Question: What visual encoding does this figure use to show its data?
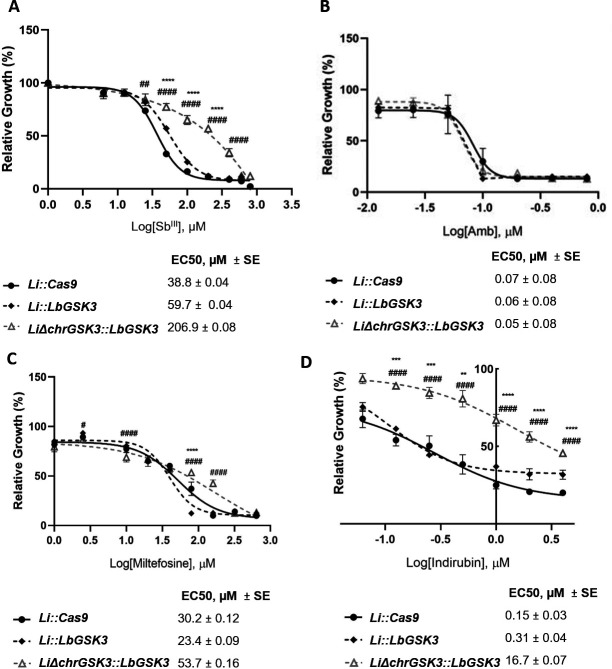
Answer: line